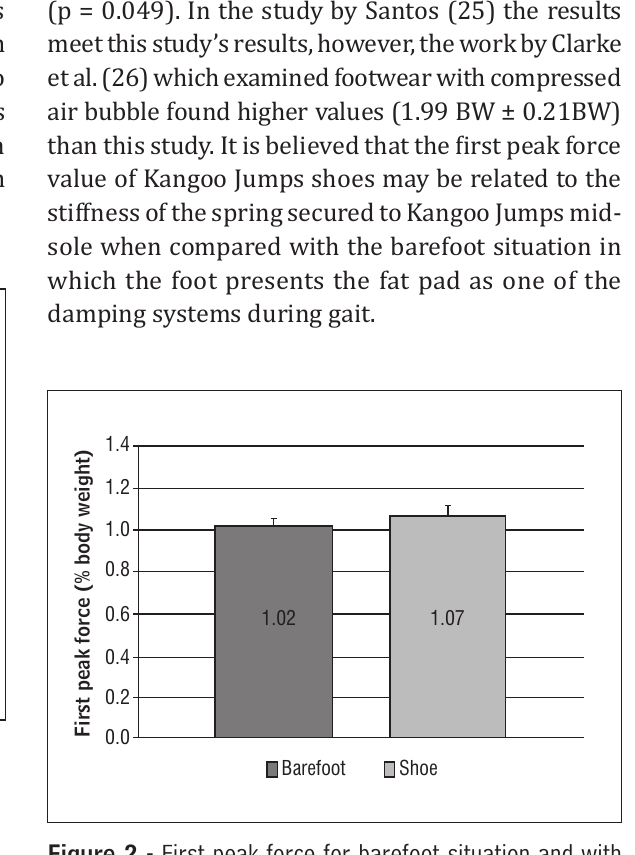
Figure 2 - First peak force for barefoot situation and with